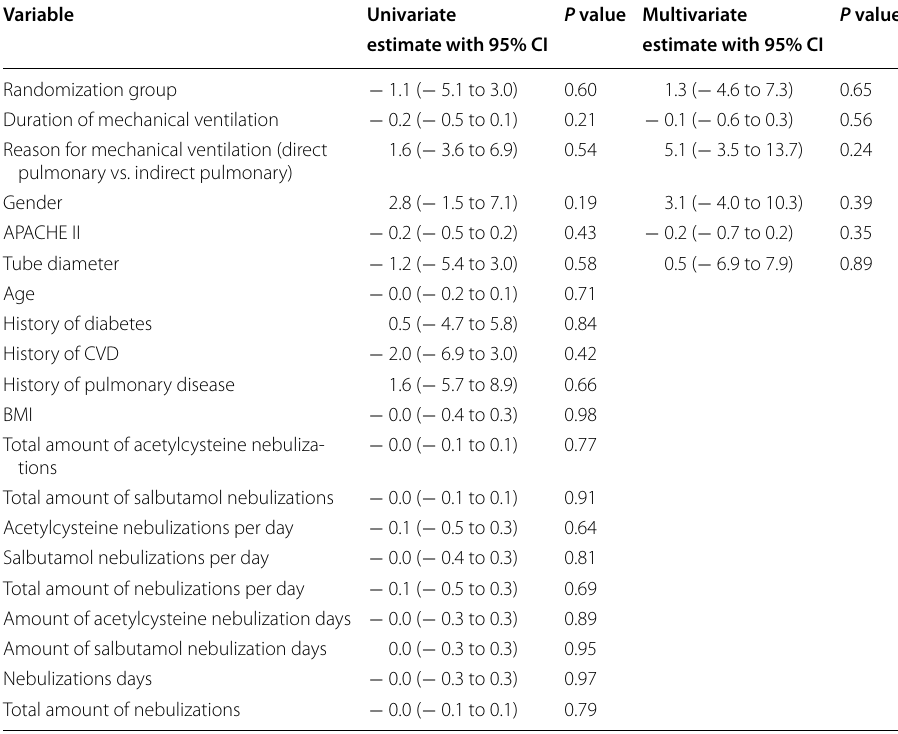
CI, confidence interval; APACHE II, Acute Physiology and Chronic Health Evaluation II; CVD, cardio‑vascular disease; BMI, body mass index